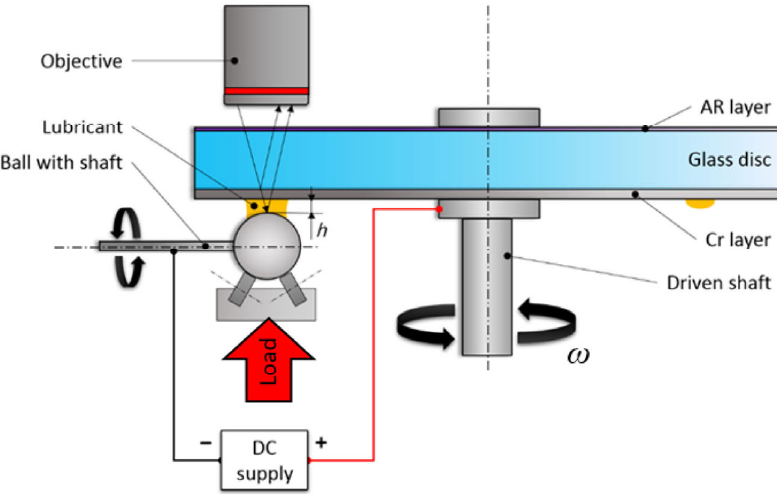
Fig. 2 Schematic representation of the optical tribometer with an excitation